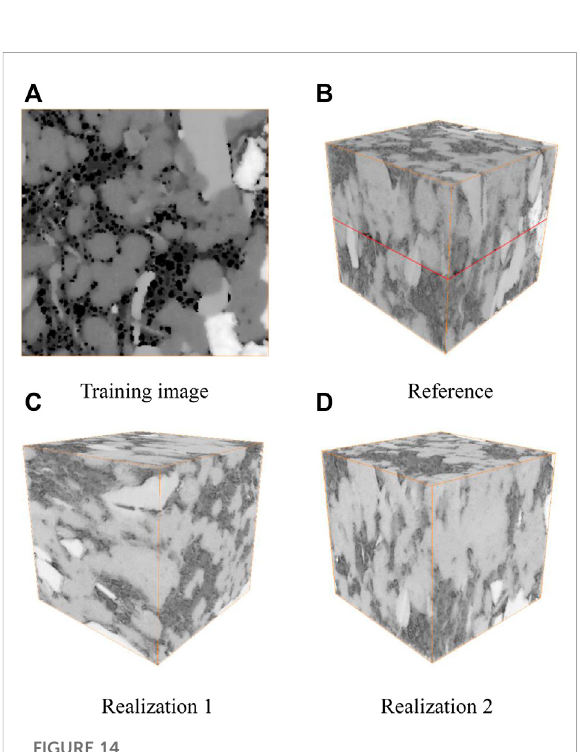
FIGURE 14 Comparison of 3D shale digital rocks (A) Training image, (B) Reference model, (C) and (D) are realizations one and two which are reconstructed based on the training image using the proposed method. Red represents the organic pore phase; green representstheorganicphase,purplerepresentstheinorganicpore phase, yellow represents the matrix phase, and light blue represents the pyrite phase.